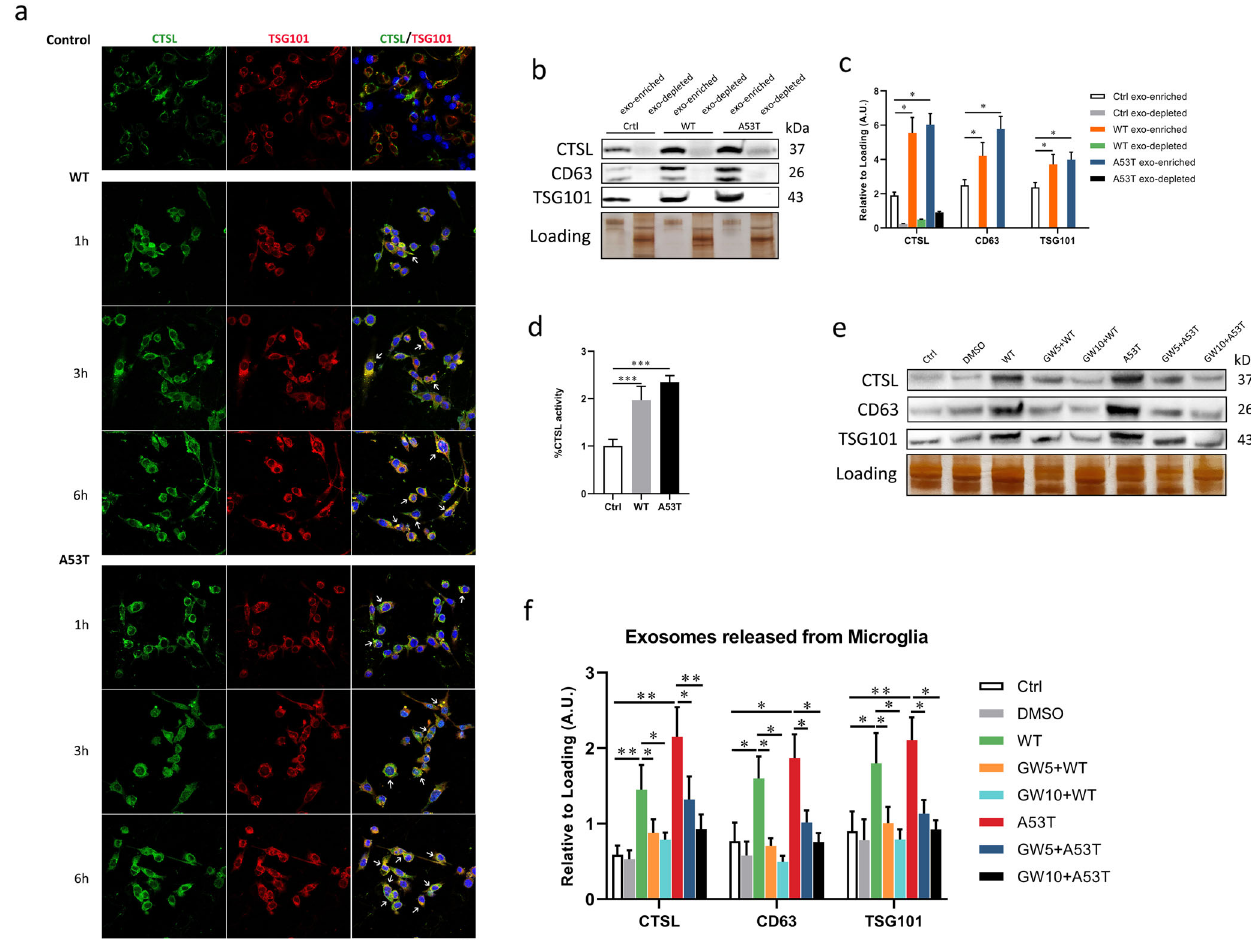
Fig. 2 The main mechanism by which CTSL is released from α -Syn oligomers-activated is exosome-mediated release. a Representative confocal microscopy images of immuno fl uorescence staining for CTSL and the speci fi c exosome marker TSG101. When primary microglia were activated by treatment with WT or A53T α -Syn oligomer for up to 6 h, the colocalization of CTSL and TSG101 (indicated by arrows) increased over time ( n = 3). Scale bar: 50 μ m. b , c The cell supernatant and secreted exosomes were isolated from the same number of microglia, and the protein levels of CTSL in both the exosome-enriched and exosome-depleted fractions were assayed by western blotting ( n = 4); * p < 0.05. d Measurement of CTSL activity in exosome-enriched lysates from untreated and α -Syn oligomers-treated microglia. Exosome lysates without the addition of substrate were used as background controls ( n = 6); *** p < 0.001. e , f Exosomes were isolated from the supernatants of control microglial and WT and A53T α -Syn oligomer-treated microglia in the presence and absence of GW4869. CTSL, CD63, and TSG101 levels in exosome lysates were measured by western blotting ( n = 4); * p < 0.05, ** p < 0.01. Ctrl = untreated control; exo = exosome; GW5 = 5 μ M GW4869; GW10 = 10 μ M GW4869. Error bars represent